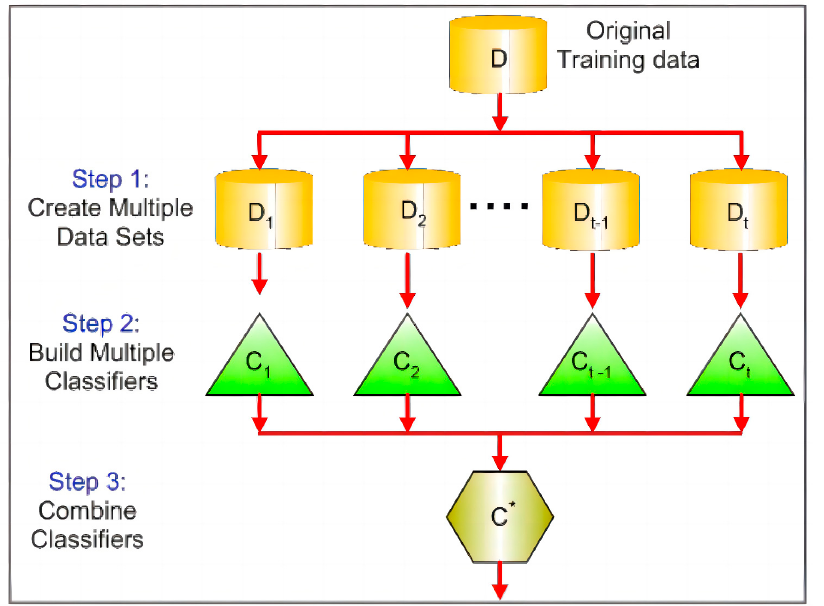
Figure 8. Flow diagram of random forest model. C* represents the symbolic representation of the combinatorial classifier[82].